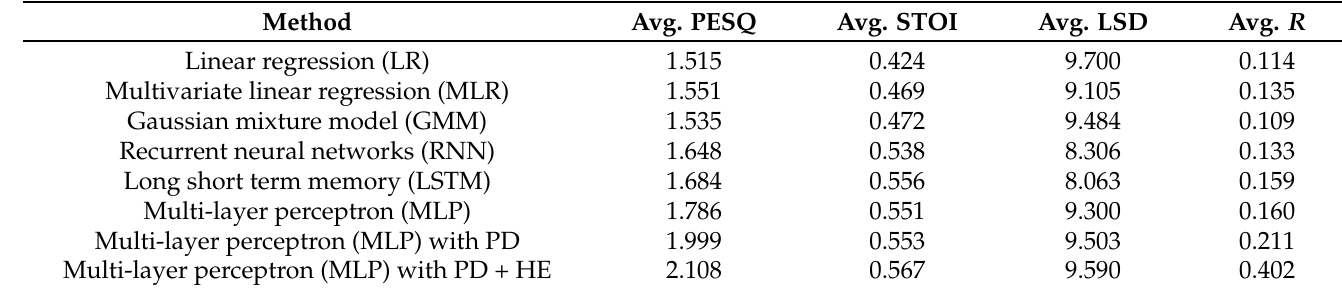
Table 4. Performance comparison of the test set for the different estimation